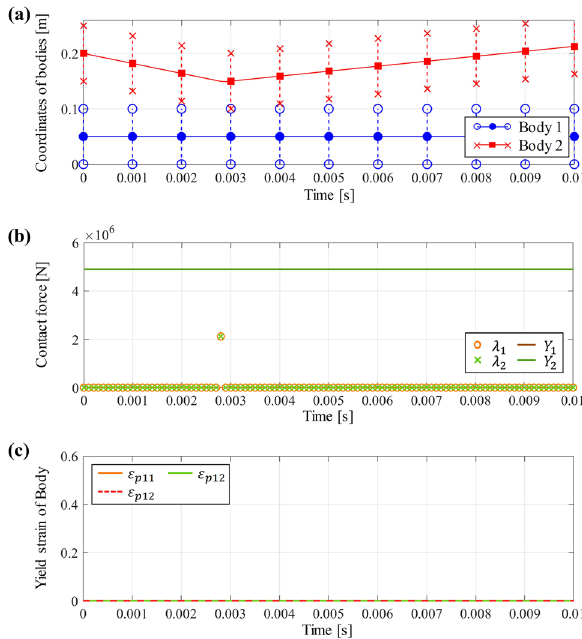
Fig. 9 Case 1: a Coordinates; b Contact force; c Yield strain